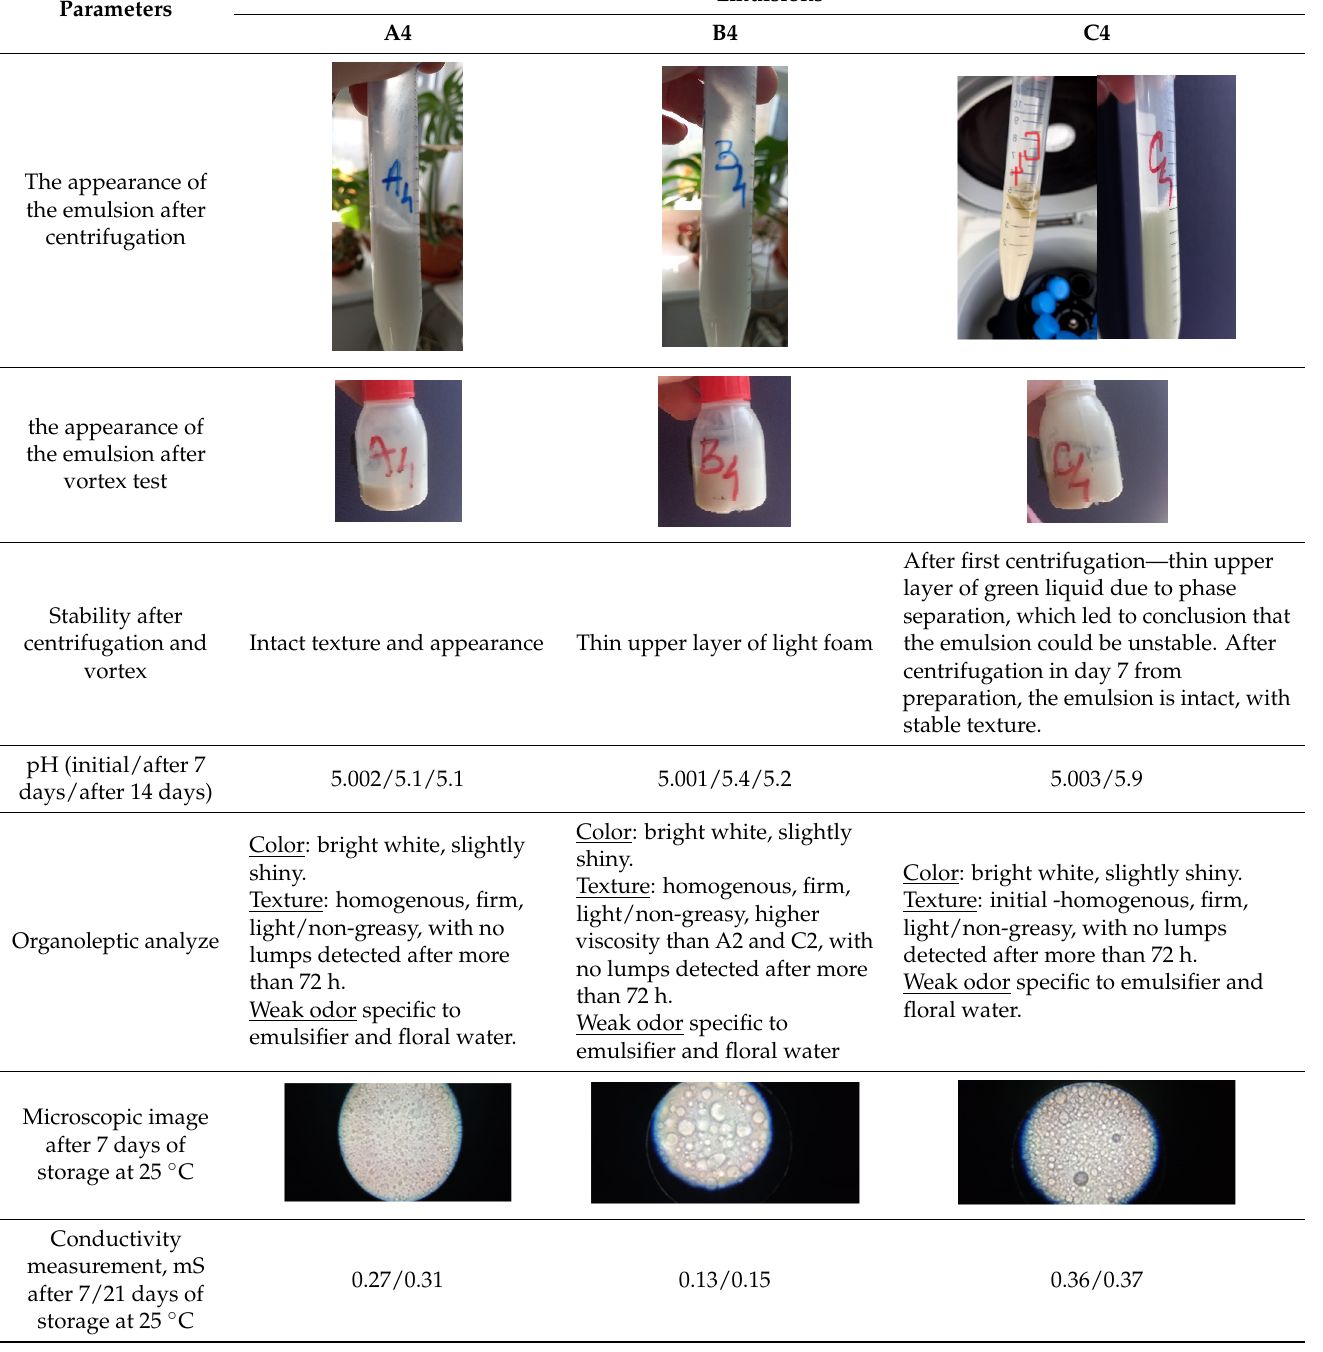
Table 5. Preliminary Characterization of Emulsions with Galium verum Extract.